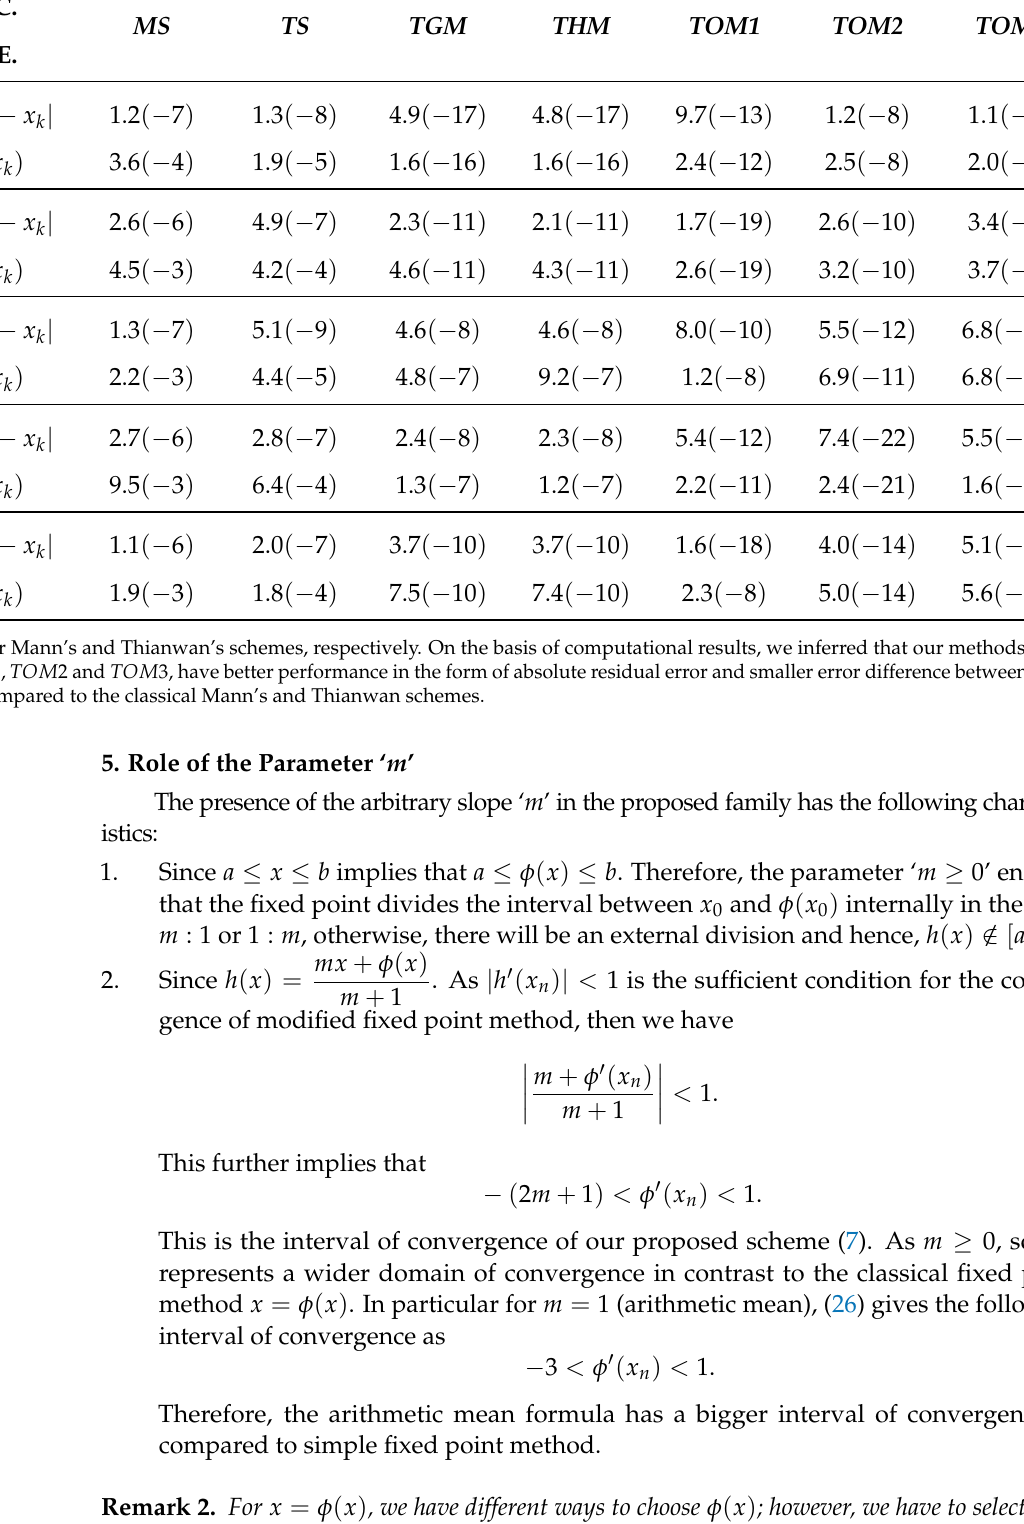
Table 5. Comparison of our methods with classical Mann’s and Thianwan method after k = 12 number of iterations.